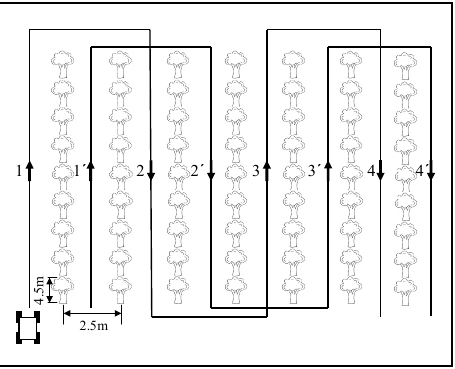
Figure 17. Automatic navigation